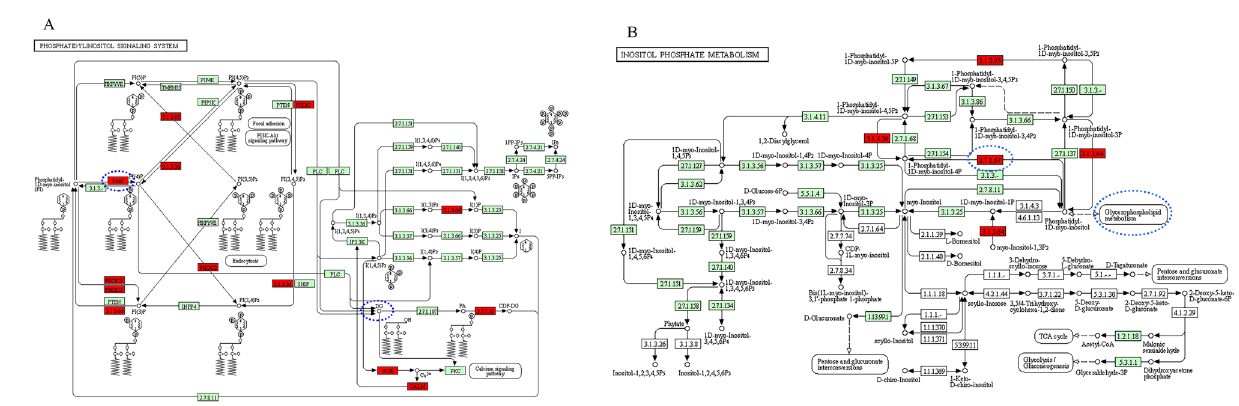
Figure 6. Localization of the DEs PI4K2A in the phosphatidylinositol and inositol phosphate metabolic pathways. ( A ) Phosphatidylinositol signaling system; ( B ) inositol phosphate metabolism; Blue dashed boxes indicate the specific location of the PI4K2A gene and the pathway involved in triglyceride